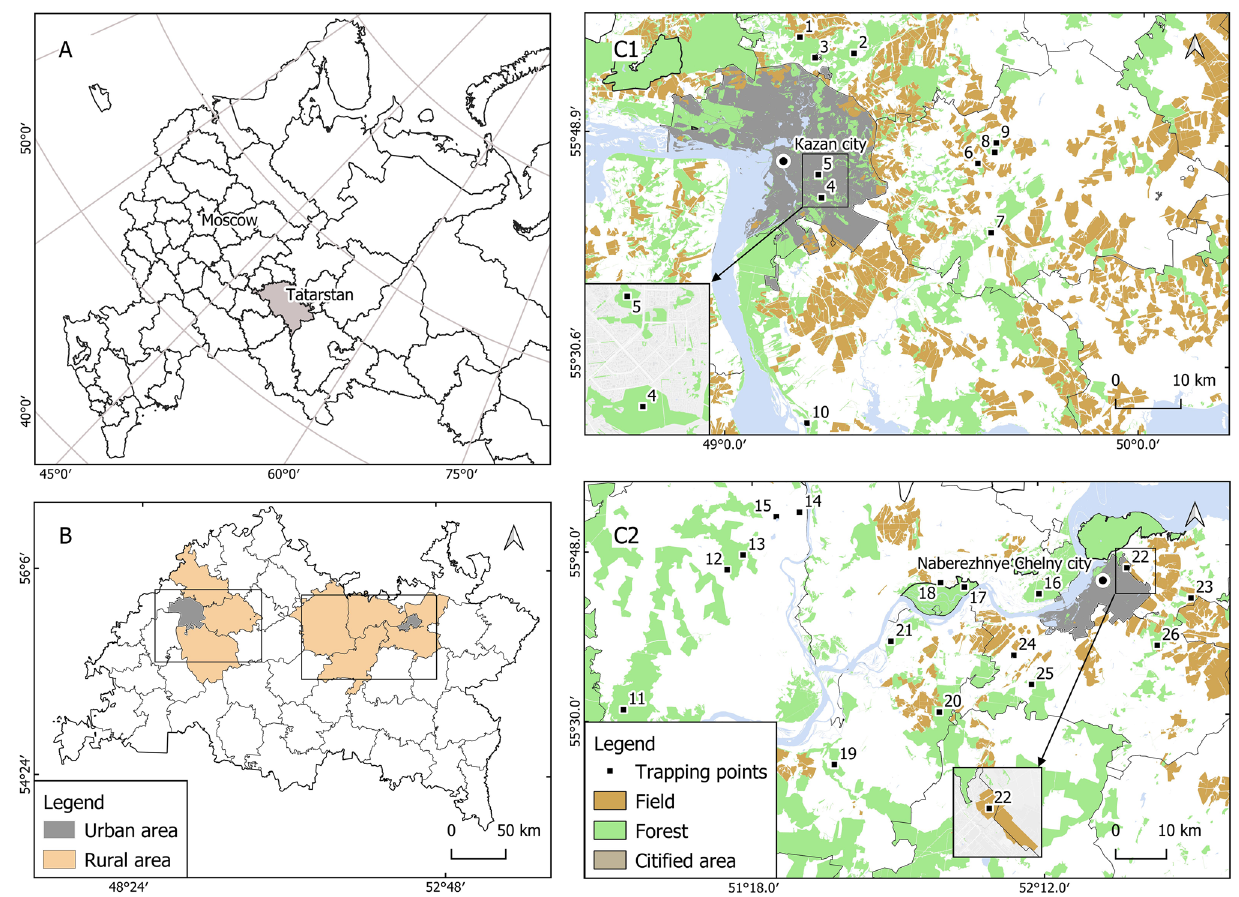
Figure 1. Map of the trapping points in Tatarstan, Russian Federation. ( A ) Overview map of the European part of Russian Federation showing the location of Tatarstan. ( B ) Administrative boundaries of urban (gray) and rural areas (beige). C1–C2. Spatial referencing of sampling sites: forests (green), fields (brown), citified area (gray). Locations of the urban areas appear as larger approximations in separate windows. Each trapping point is indicated by a number. Set of vector data layers was purchased from NextGIS (OpenStreetMap and contributors, 2021. Data license: ODbL. Accessed via https:// data. nextg is.